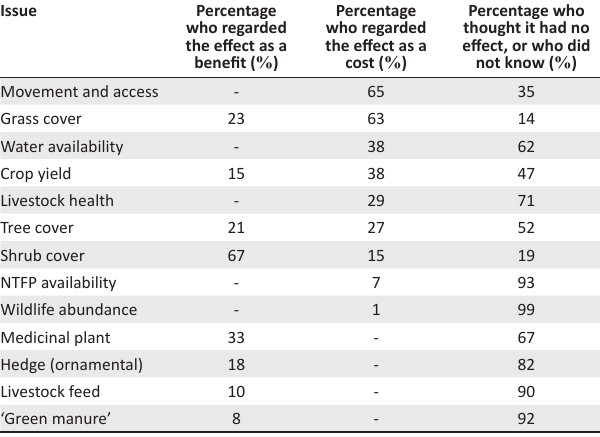
TABLE 1: The percentage of respondents ( n = 166) who regarded the effect of Tithonia diversifolia on a particular issue as either positive or negative, or who had no opinion on the issue, in the Copperbelt province, Zambia.